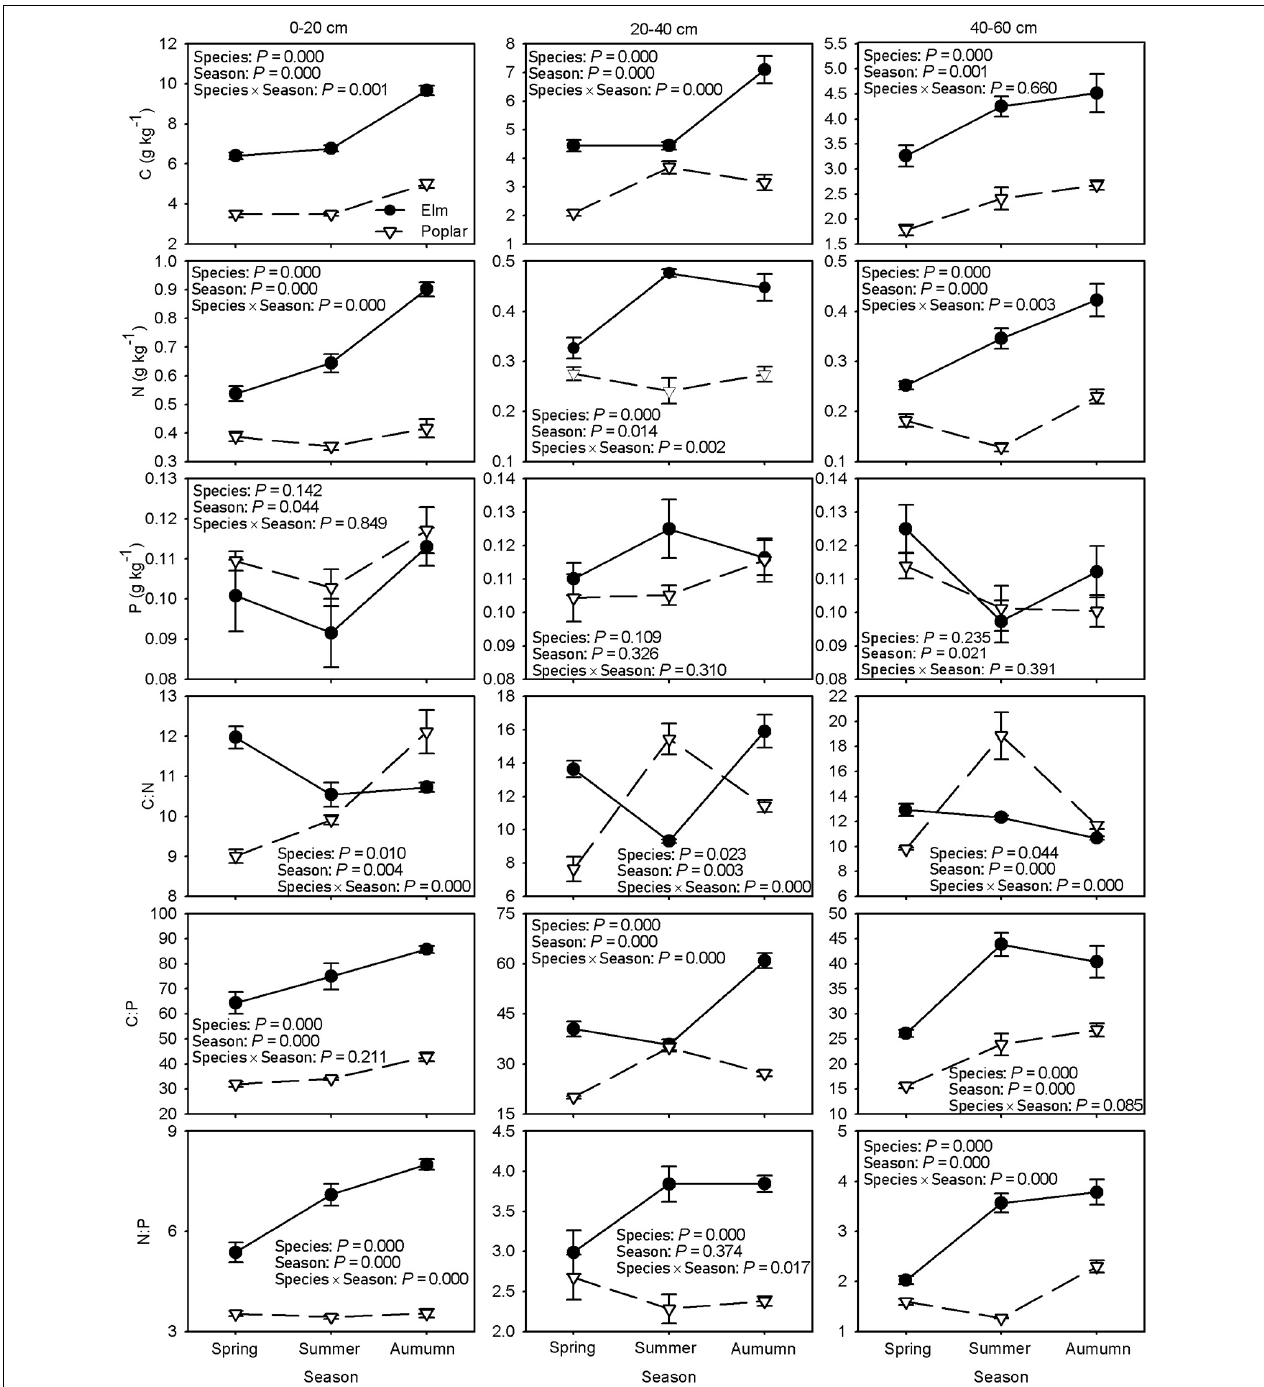
FIGURE 2 | Differences in soil C, N, and P concentrations and C:N, C:P, and N:P across the growing season between Siberian elm and Silver poplar plantations ( n = 3).